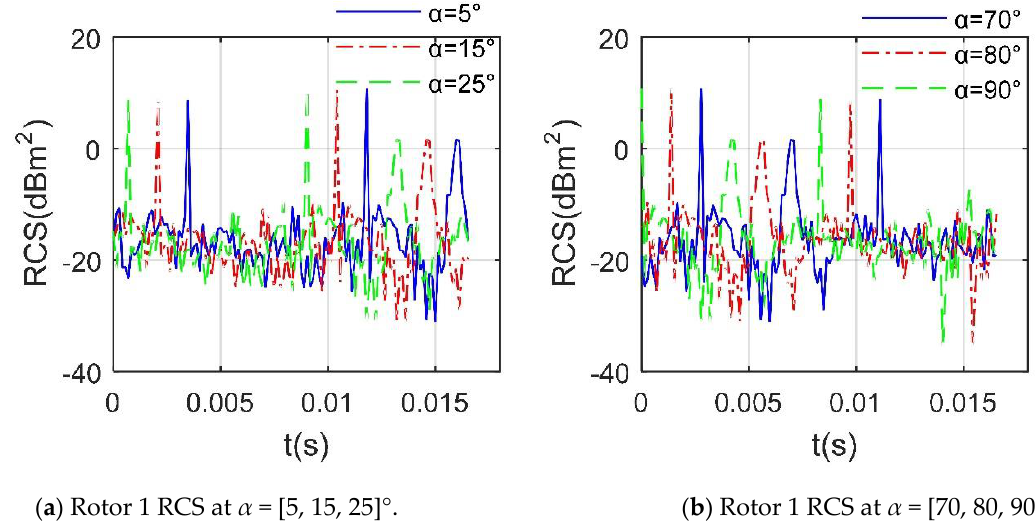
Figure 9. Dynamic RCS of rotor 1 at different azimuths, f RH = 10 GHz, β = 5°, n r1 = 1200 r/min.